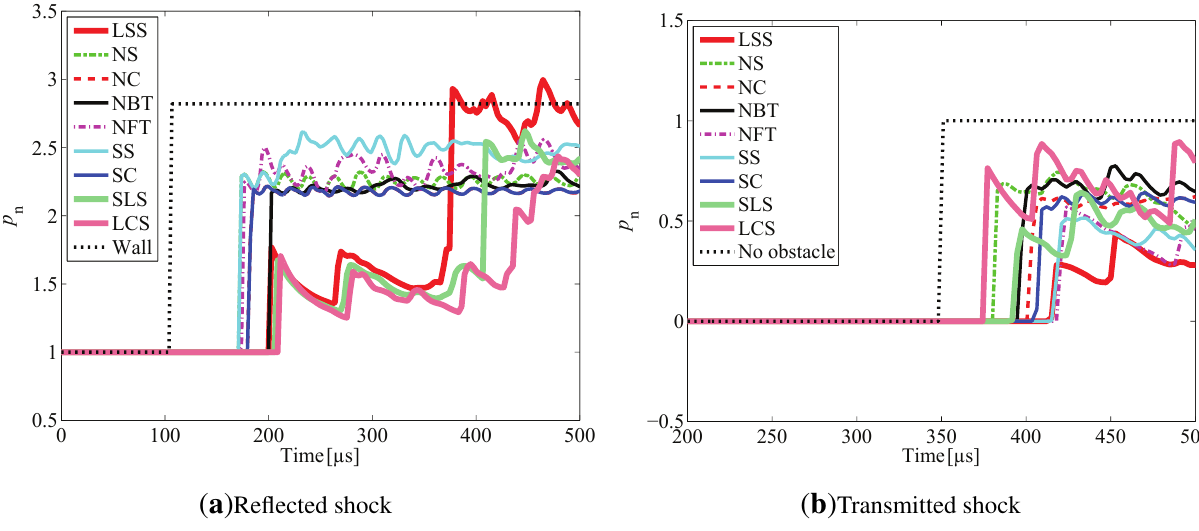
Figure 7. Plot of dimensionless pressure, p ( b ) downstream probe ( x, y ) = (169 . 4 , 0) , as functions of time for all